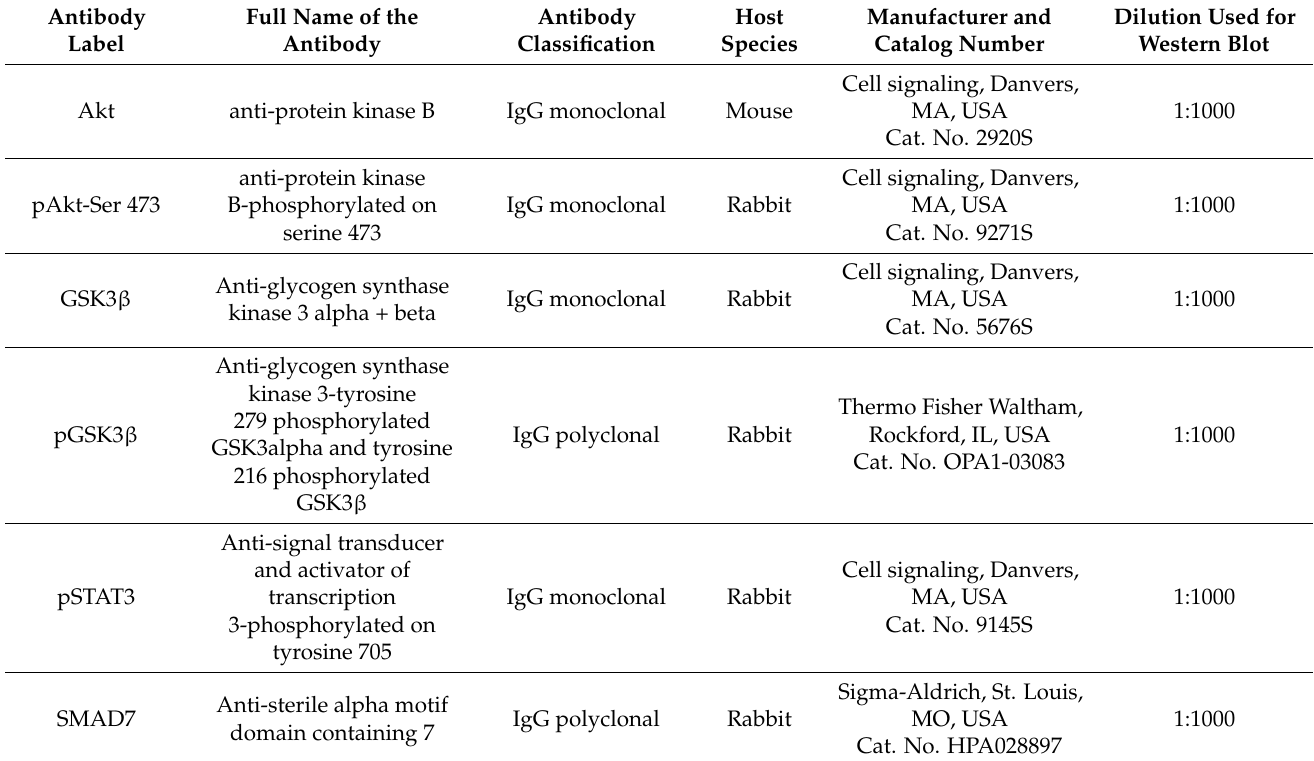
Table 1. List of primary antibodies used in the Western blot method.